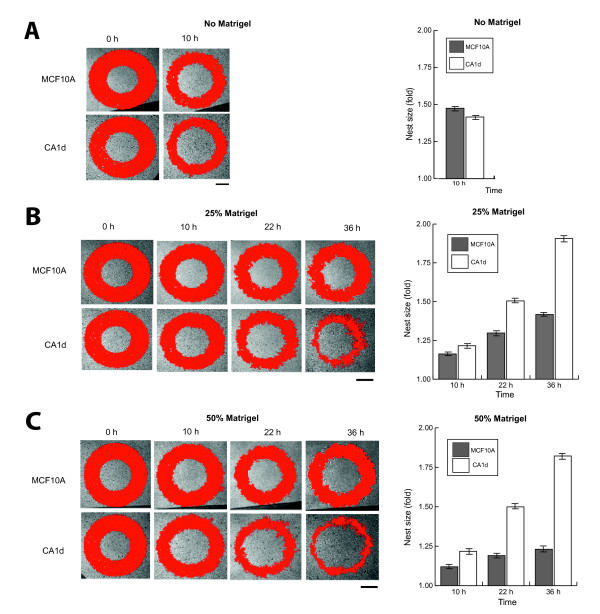
NEA: Matrigel Overlay Differentiates Invasiveness in vitro. For this technique, artificial wounds were created with a silicone-tipped drill press to leave uniform, circular "nests" within a confluent monolayer of MCF10A or CA1d cells in Petri dishes, and Matrigel (25% or 50%) was added where indicated. Time-lapse images (0, 10, 22, 36 h) of expanding nests were obtained using a Zeiss Axiovert 200 M microscope equipped with a Hamamatsu ORCA-ER CCD camera (2.5×; scale bars = 500 μm). Nest expansion was calculated using ImageJ after applying thresholding and pseudo-color (red) functions to images. All values are presented as the mean ± standard deviation for each cell line, to reflect the fold increase in pixel number of each nest captured at each time point of interest, compared to the same nest at time point 0 h. (A) In the absence of the Matrigel overlay, the non-aggressive MCF10A cell line expanded significantly more than the aggressive, invasive CA1d cells after 10 h (N = 8; P = 0.03). However, time points 22 h and 36 h were immeasurable (results not shown) because all nests fully expanded into the outer ring of the remaining cell monolayer after this duration of incubation. (B/C) In contrast, in the presence of 25% or 50% Matrigel, CA1d nests expanded significantly more than MCF10A nests at all time points measured after 0 h (N ≥ 8; P < 0.05 in all cases). These results suggest that the ECM-like component is key to capturing cell lines' invasive potentials, at least for these cells.